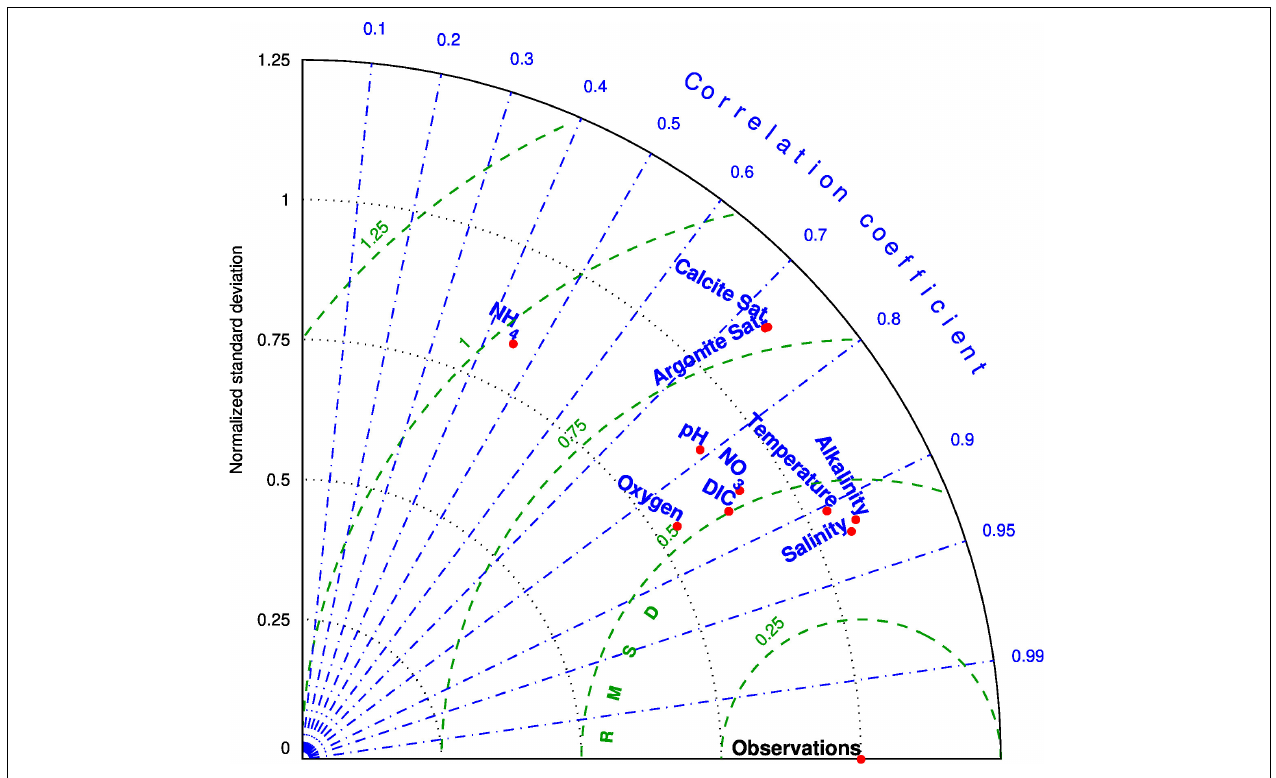
FIGURE 4 | Taylor diagram of the model results for 2010 to 2017 over the whole domain. The blue dash-dot lines on the diagram represent the coefficient of correlation between the simulated and observed values. The green curved broken lines indicate the centered root mean square difference (RMSD) between the simulated and observed values. Finally the dotted lines show the normalized standard deviation of the simulated variables compared to the standard deviation of the observed field (value of 1.0). The closer the simulated values are to the point marked “Observations” on the x -axis the better the